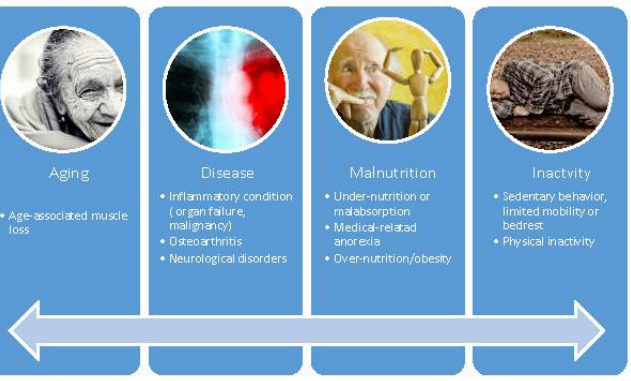
Figure 1. Factors that cause and worsen muscle quantity and quality are classified as primary (aging) and secondary (disease, inactivity, and poor nutrition).